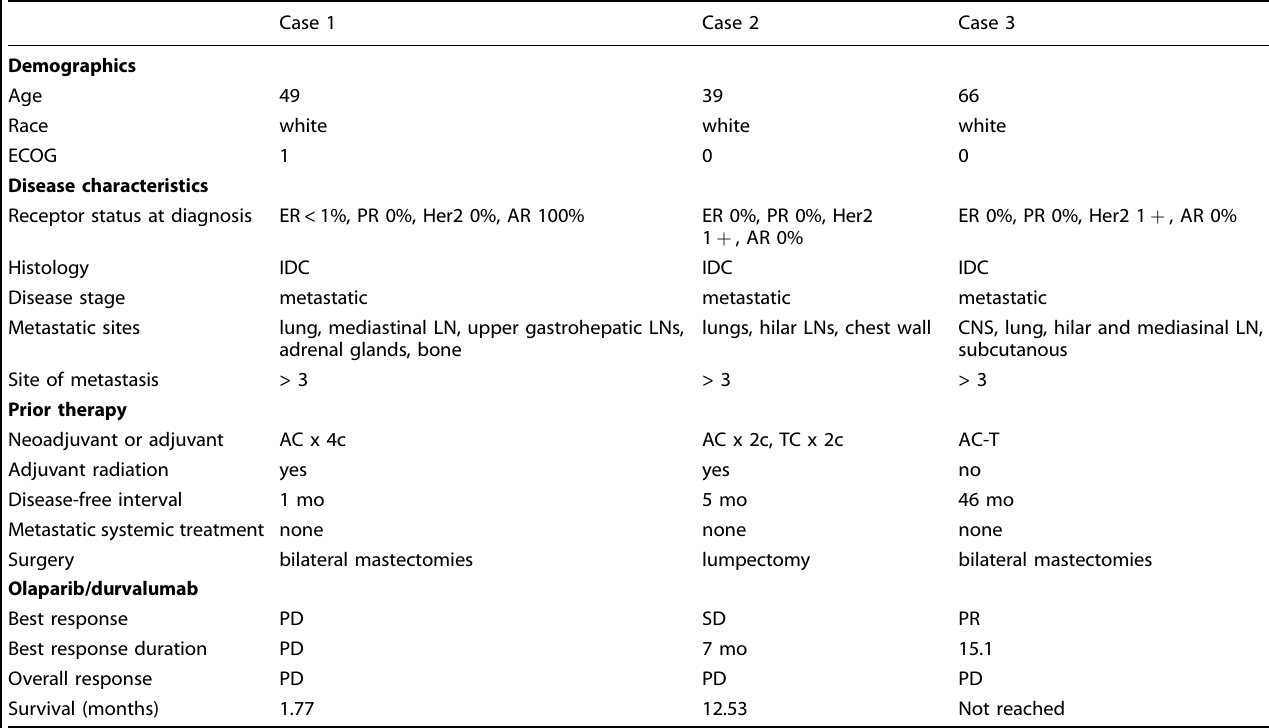
Table 1. Patient ’ s characteristics.